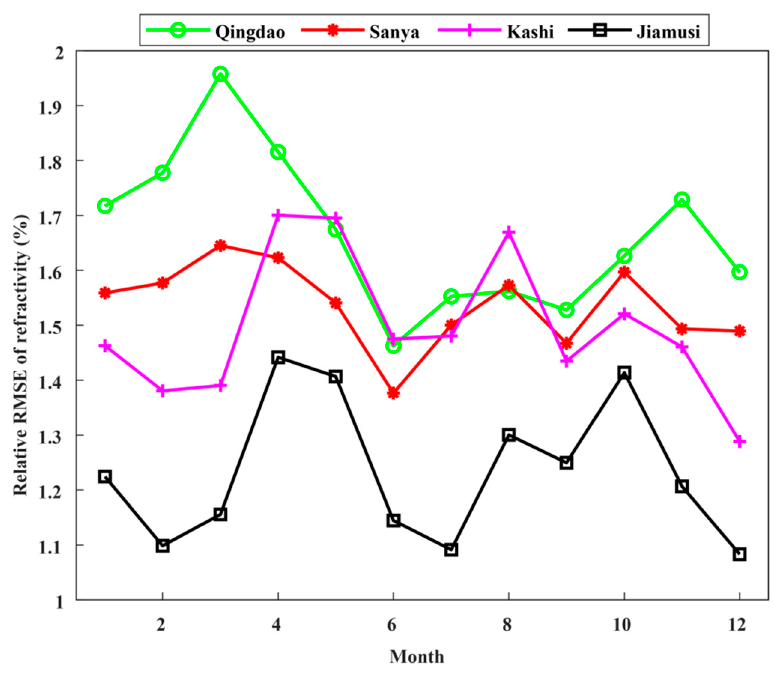
Figure 13. The relative RMSE of refractivity profile in different months.